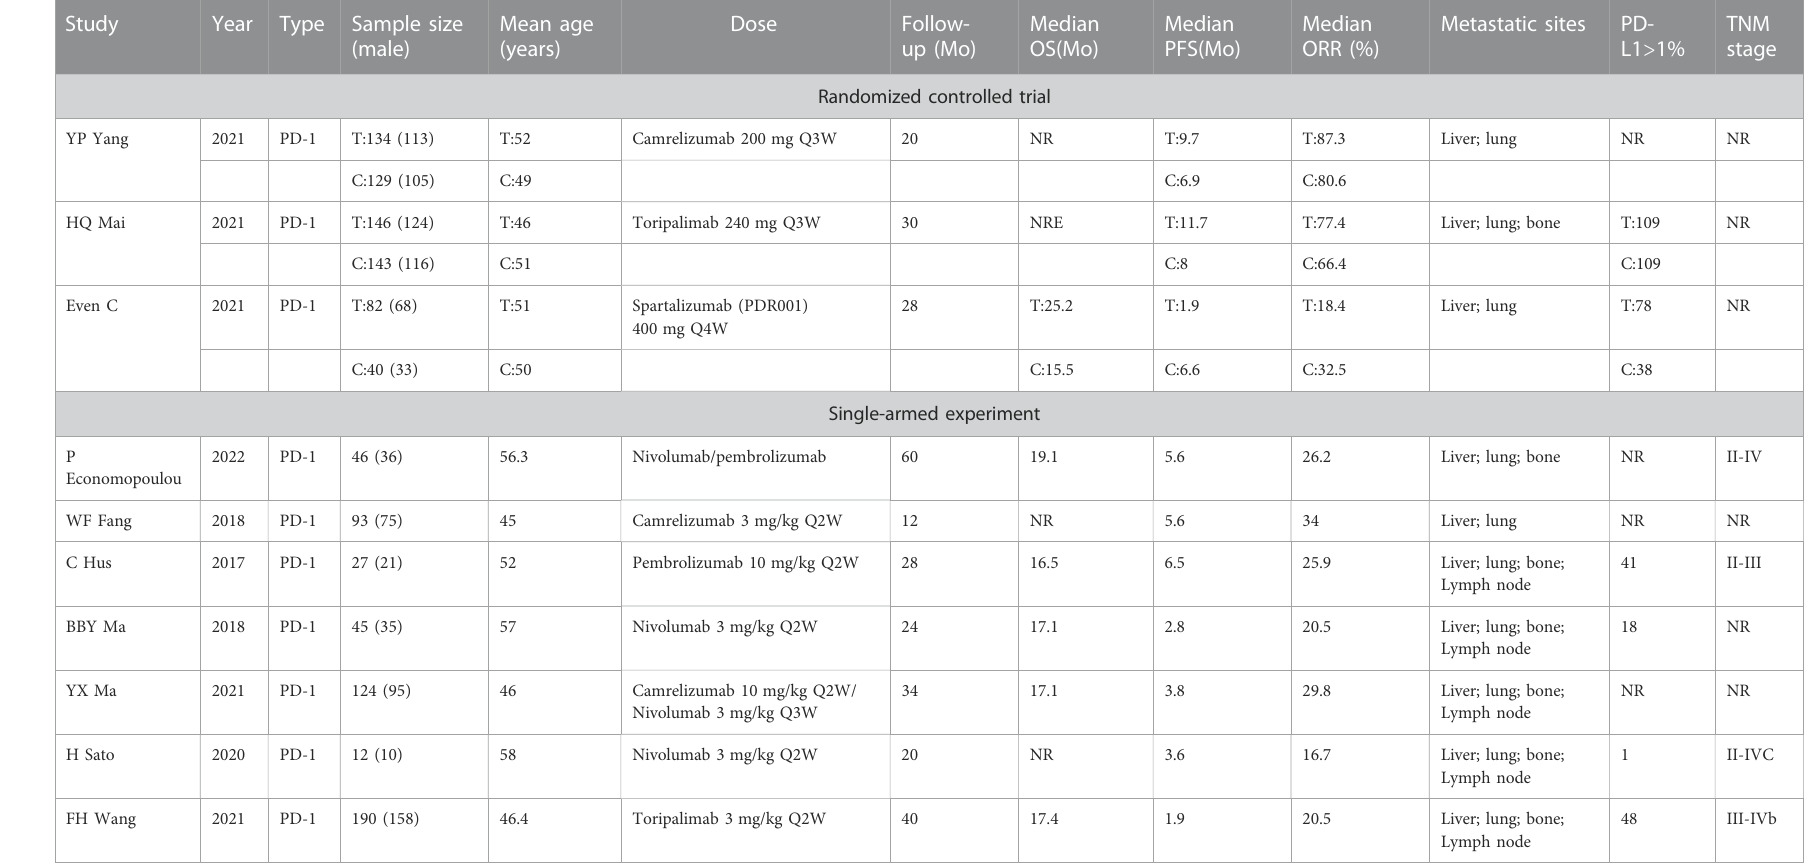
TABLE 1 Literature baseline table.